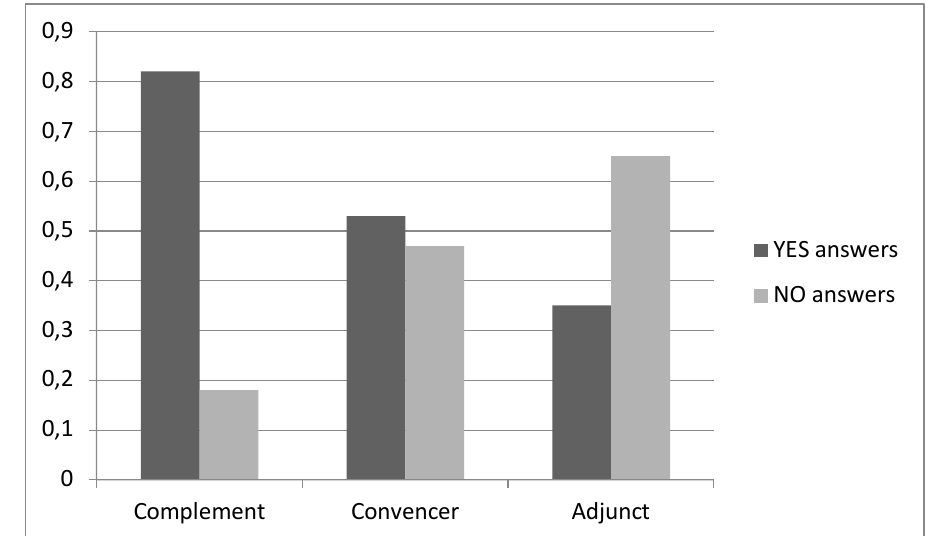
Figure 11 . Proportion between YES and NO